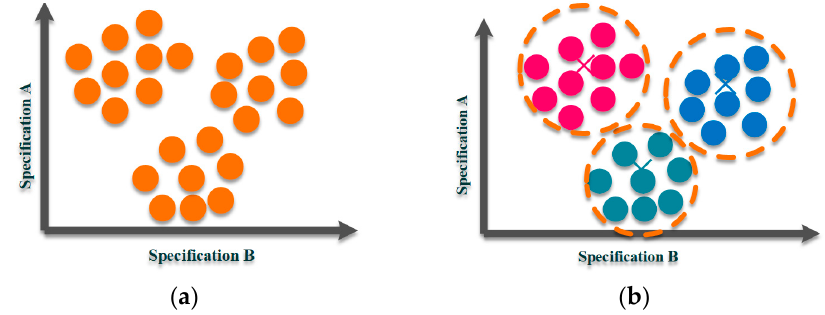
Figure 18. The basic structure of k-mean: ( a ) before using k-mean; ( b ) after using k-mean